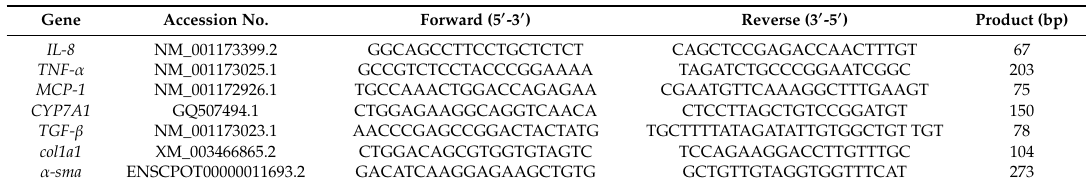
Table 2. q PCR primer